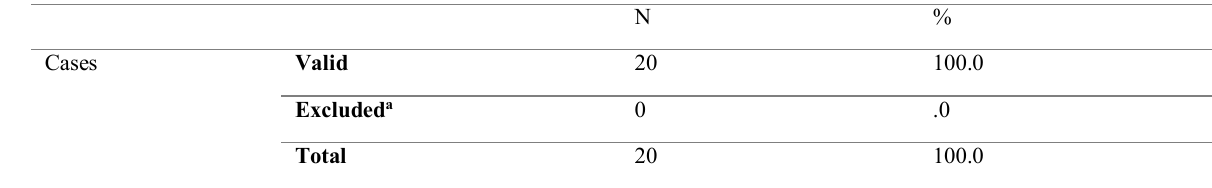
Table 3a: Case processing summary and reliability